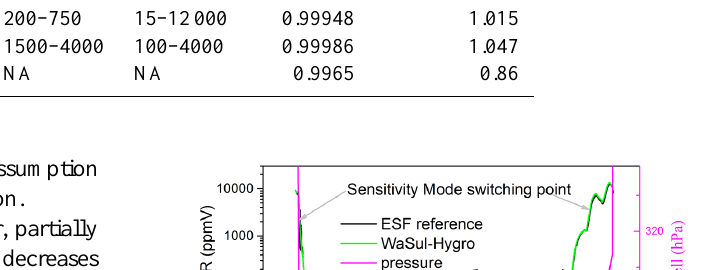
Table 1. Results from comparisons of WaSul-Hygro with other instruments during laboratory and flight tests. In the case of the comparison with the WS-CRDS system above 4000ppmV, there were no comparable numbers of data available, so the upper limits of the 2 and 5% coincidences are certainly higher. Relative difference ranges from reference instruments (ppmV) Pearson Reference Within correlation Slope of cross- instrument noise level